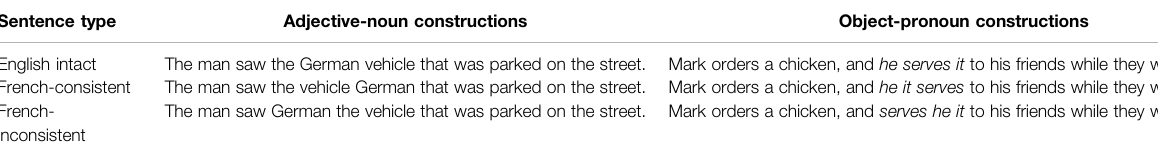
TABLE 1 | Sample sentences containing adjective-noun and object-pronoun constructions across